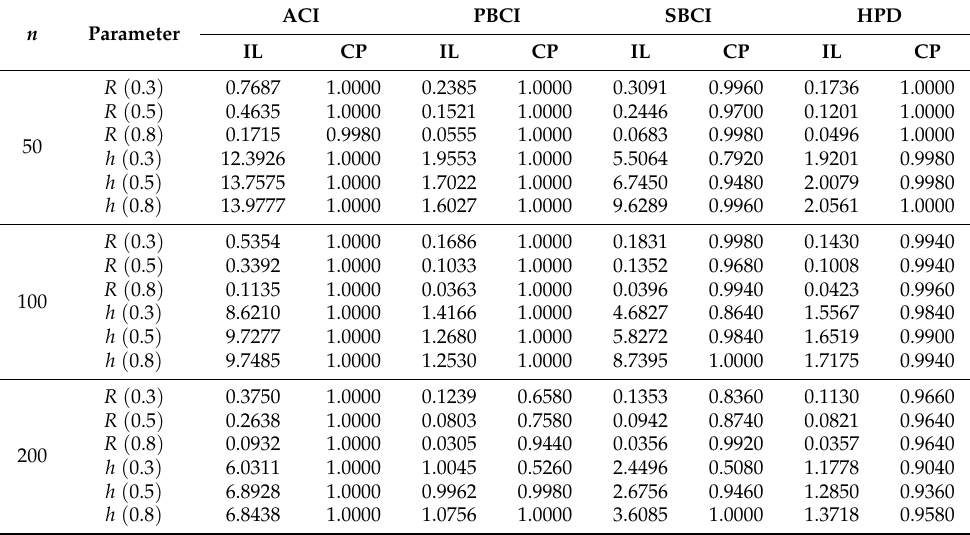
Table 11. Interval estimates of R ( x ) and h ( x ) at x = { 0.3,0.5,0.8 } under Scheme 2.